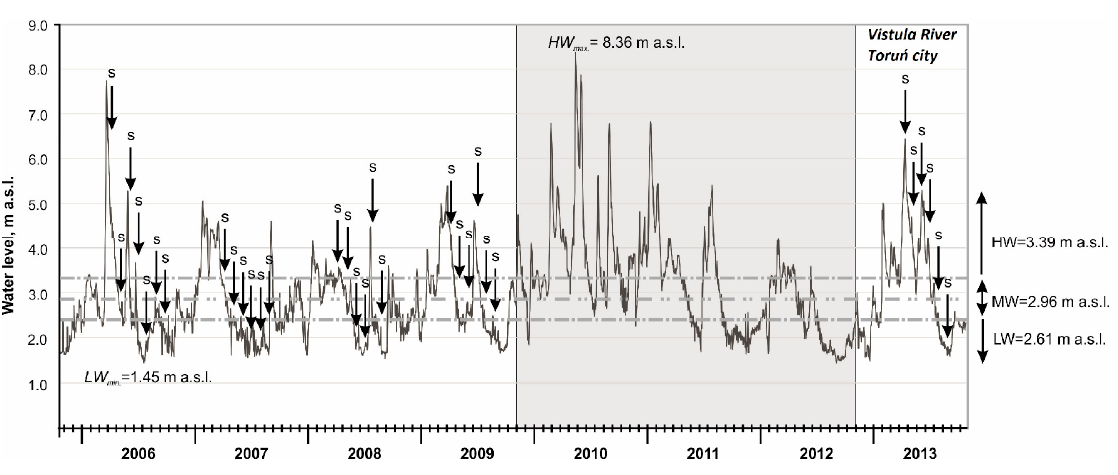
Figure 3. Non ‐ metric multidimensional scaling analysis (nMDS) of the environmental conditions (Secchi disk visibility (SD), temperature (T W ), dissolved oxygen (DO), conductivity (EC) and pH) (Stress: 0.004) in three types of floodplain lakes (FL1—isolated; FL2—transitional; FL3—connected). The highest average water transparency (1.45 m) was noted in the isolated lake, and the lowest (0.63 m), in the connected lake ( K – W = 33.73, p ≤ 0.001). In contrast, the differences in average temperatures (T w ) and conductivity (EC) among the studied floodplain lakes were not statistically significant. The highest average temperature was recorded in the connected lake (20.0 °C), and the